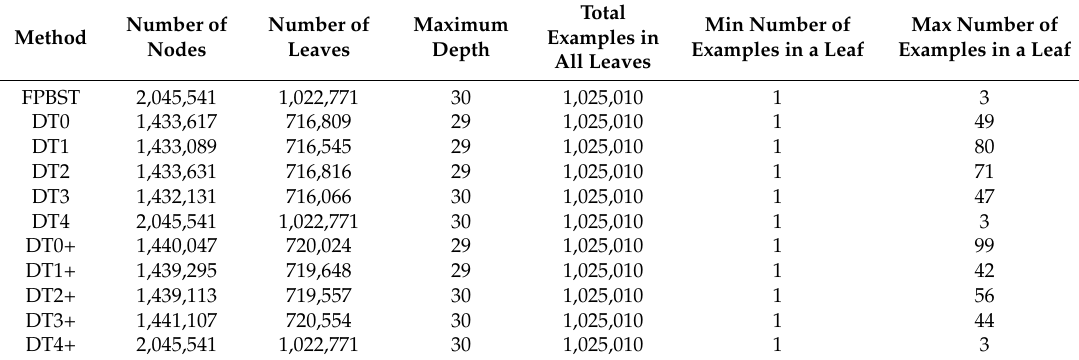
Table 3. Some specifications of the resultant BST of the FPBST compared to the resultant DTs after applying the proposed FPDTs on the poker dataset (training